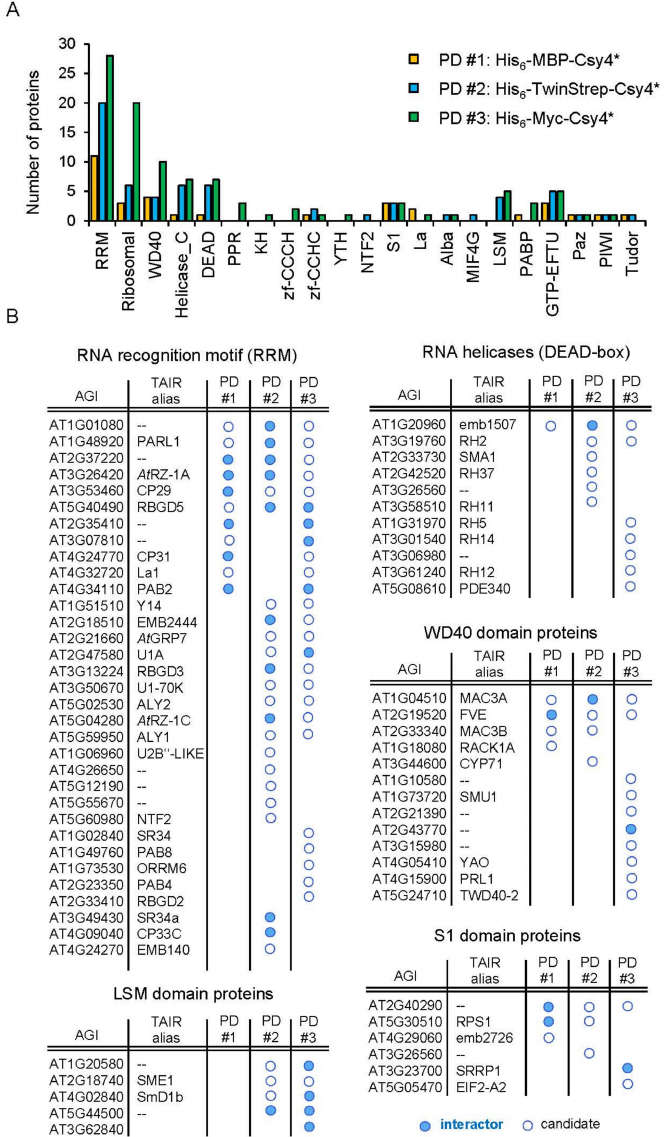
Figure 3. Systematic categorization of co-purified proteins. ( A ) Number of proteins harboring domains associated with RNA-binding in RNA pulldowns using His 6 -MBP-Csy4* (yellow), His 6 -TwinStrep-Csy4* (blue) and His 6 -Myc-Csy4* (green). ( B ) Overview of co-purified proteins containing a recognized RNA- binding domain. Shown are interactors and candidates containing an RNA recognition motif (RRM), a LSM domain, a DEAD-box helicase domain, a WD40 domain and/or S1